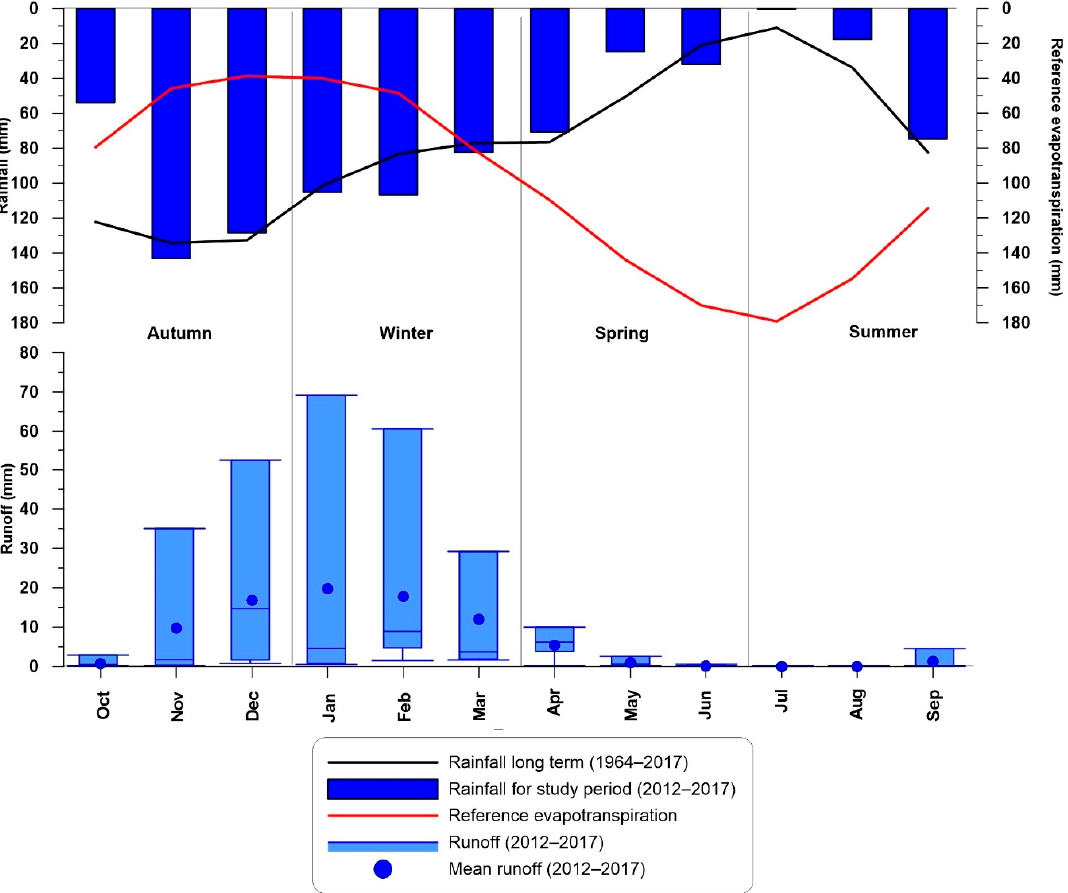
Figure 5. Monthly time series of rainfall, R, reference evapotranspiration during the study period (2012–2017) at Es Fangar Creek. Box plots show minimum, median and maximum monthly R. Blue dots show mean monthly R. Long term (1964–2017) monthly rainfall distribution is also depicted.